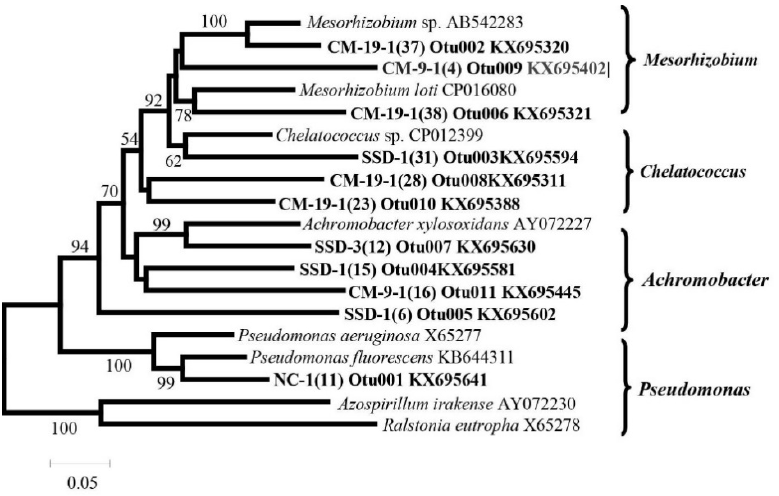
Figure 2. Phylogenetic distribution of 11 representative OTUs of the nosZ gene. Tree was constructed by the sequences obtained from sand dune sampling sites and additional their closely matched sequences from GenBank.